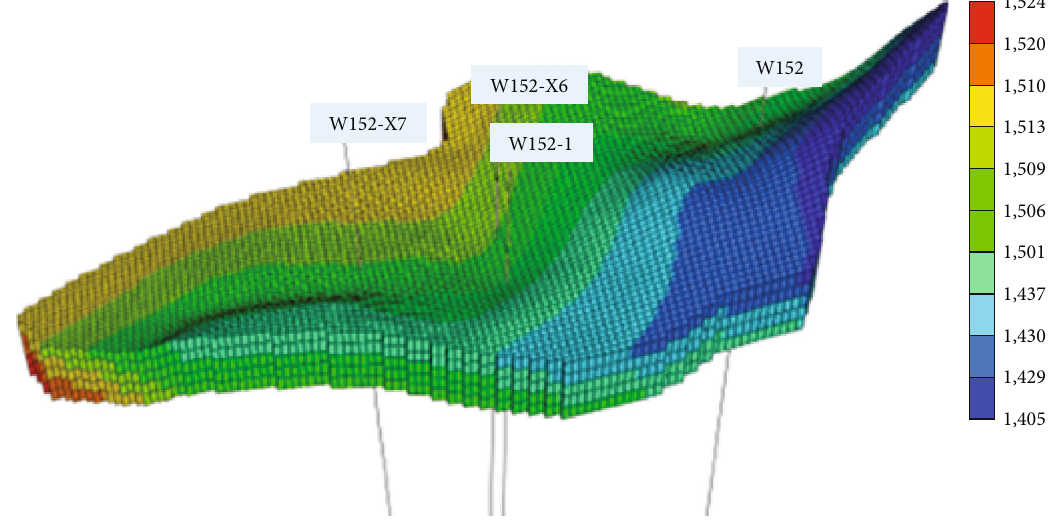
Figure 7: 3D geological model of the pilot test well group. Table 4: Rock